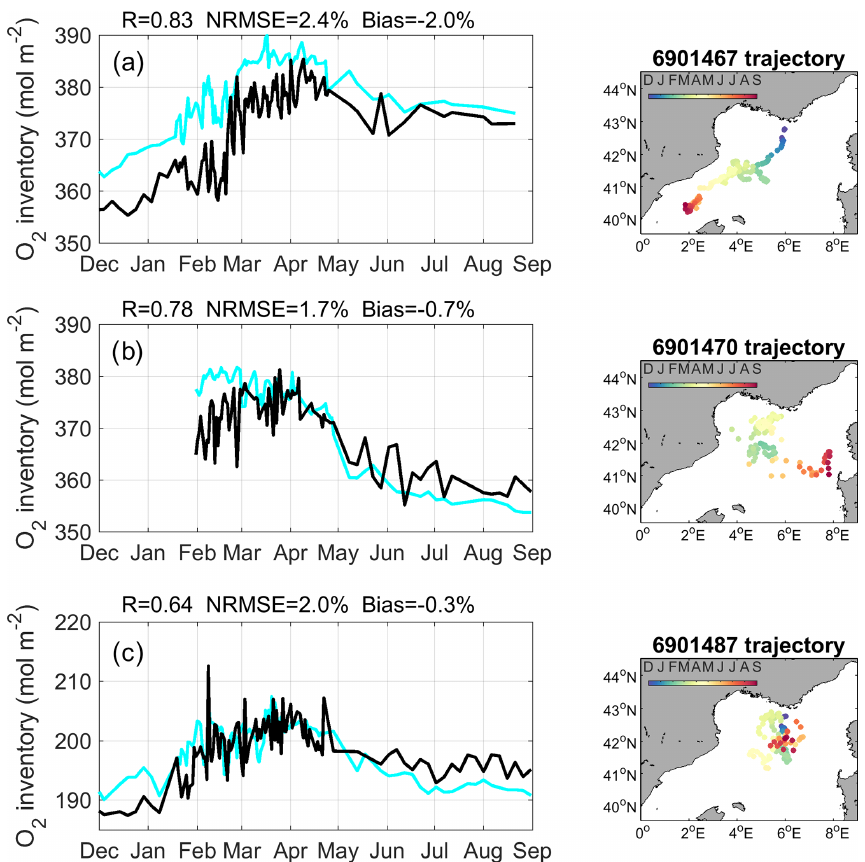
Figure 5. The left column shows oxygen inventory integrated from the surface to 1800m depth ( a and b ) or 1000m (c) (molm − 2 ) in Argo float measurements (cyan) and model outputs (black) along Argo (a) 6901467, (b) 6901470 and (c) 6901487 float trajectories. The right column shows trajectories of corresponding Argo